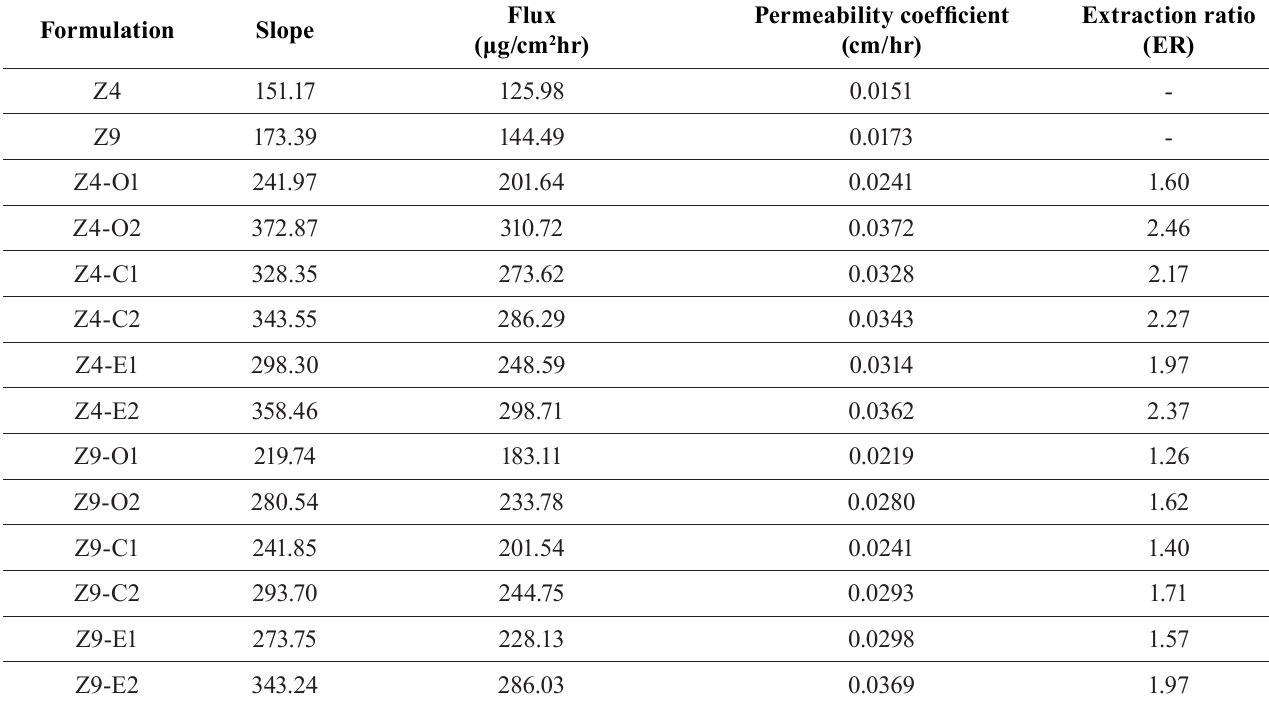
Table V - S lope, flux, permeability coefficient and enhancement ratio (ER) of Metoclopramide matrix patch.